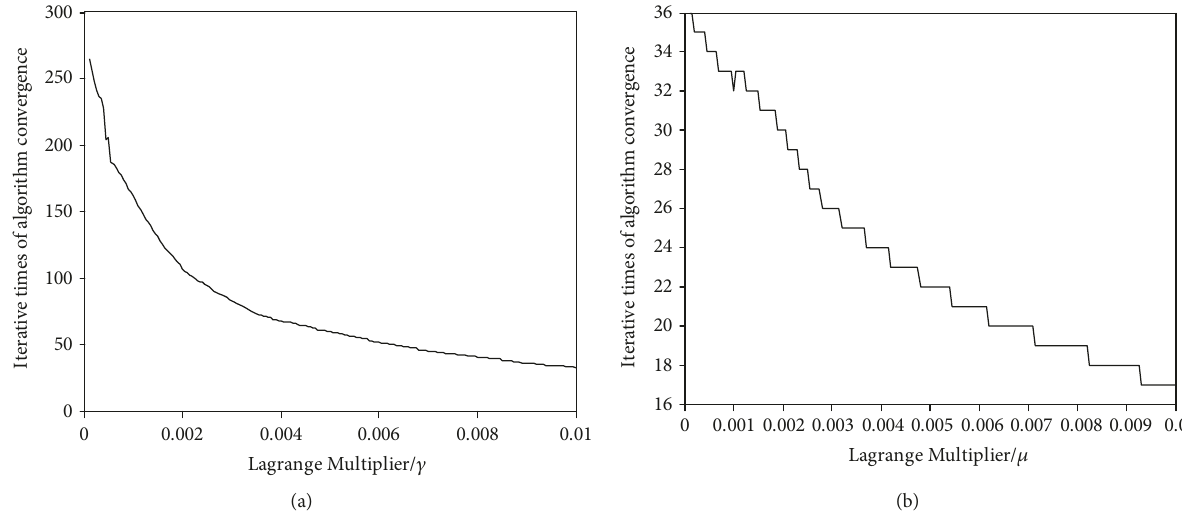
Figure 5: The in fl uence of parameters on the convergence of the algorithm. (a) Convergent curve ( μ = 0 001 ). (b) Convergent curve ( γ = 0 01 ).